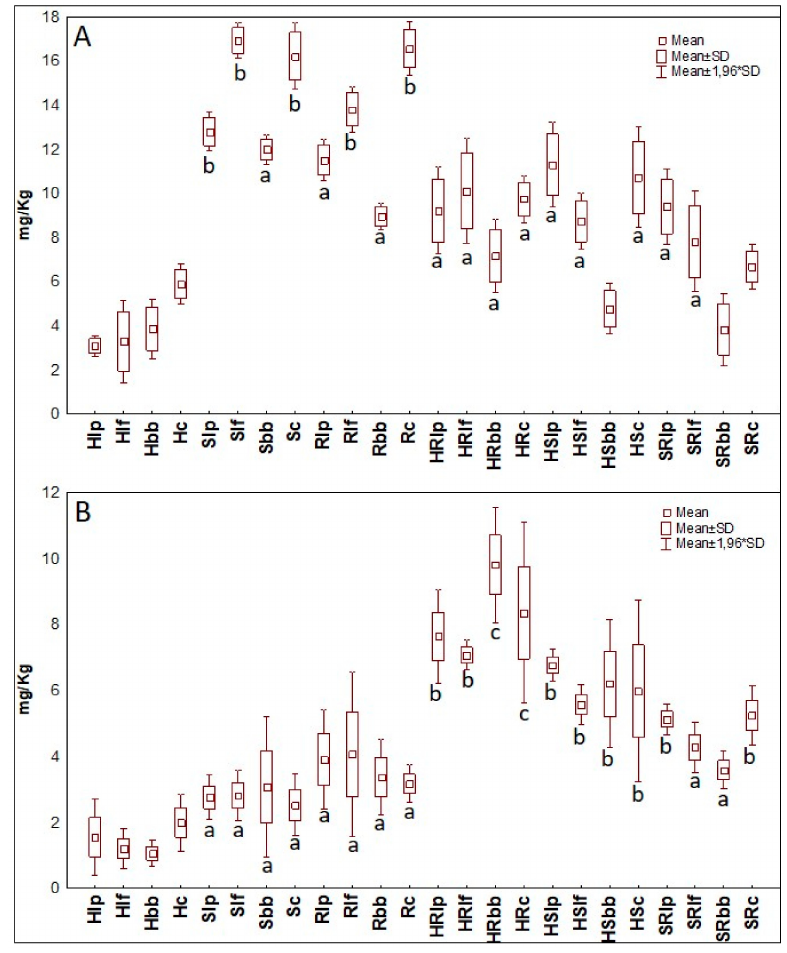
Figure 2. ( A ) Mean values in mg / Kg of ethyl alcohol for each fermented case. ( B ) Mean values in mg / Kg of acetic acid for each fermented case. a, b, c = Means with di ff erent letters are significantly di ff erent at p < 0.05 by Tukey’s test. Hlp = 100% hemp seed drink fermented with Lb. plantarum 98b;